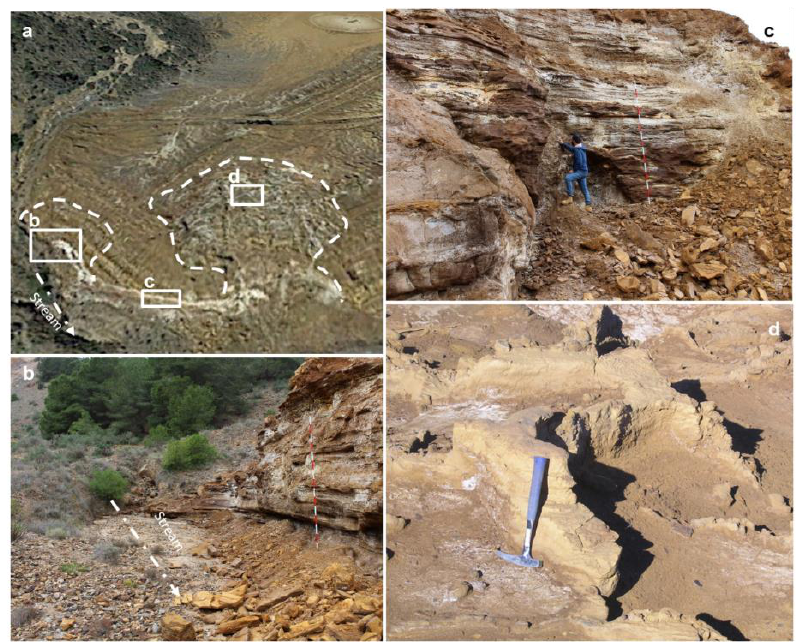
Figure 8. ( a ) Obliquus view of landslide one (LL1) and two (LL2); the discontinuous arrow indicates the direction of the stream runoff; source Spanish National Geographic Institute-IGN and Google Earth© landslide one. Detailed views landslide one (LL1) ( b ) and landside 2 (LL2) ( c ). ( d ) Sand dikes exposed on the surface of landslide two (LL2).